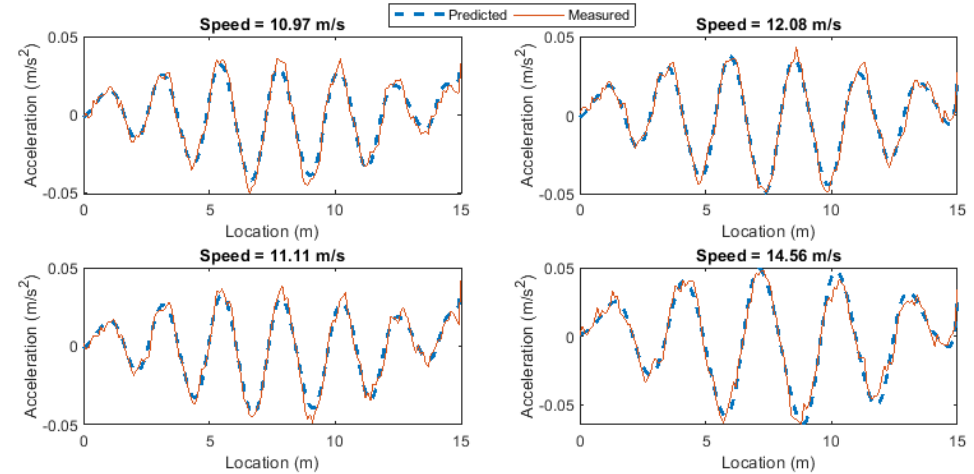
Figure 5. The comparison of the predicted and measured vehicle responses for the first four passes over the healthy bridge.